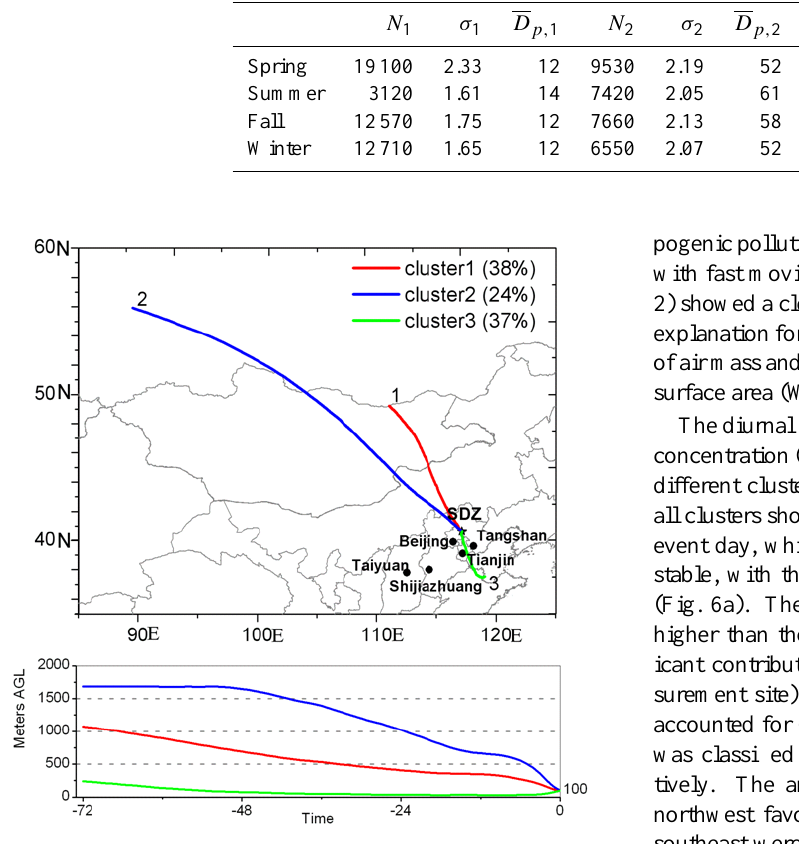
Figure 4. Mean back trajectories for 3 trajectory clusters arriving at SDZ from different height, 3 dots indicating the main cities of North China Plain.